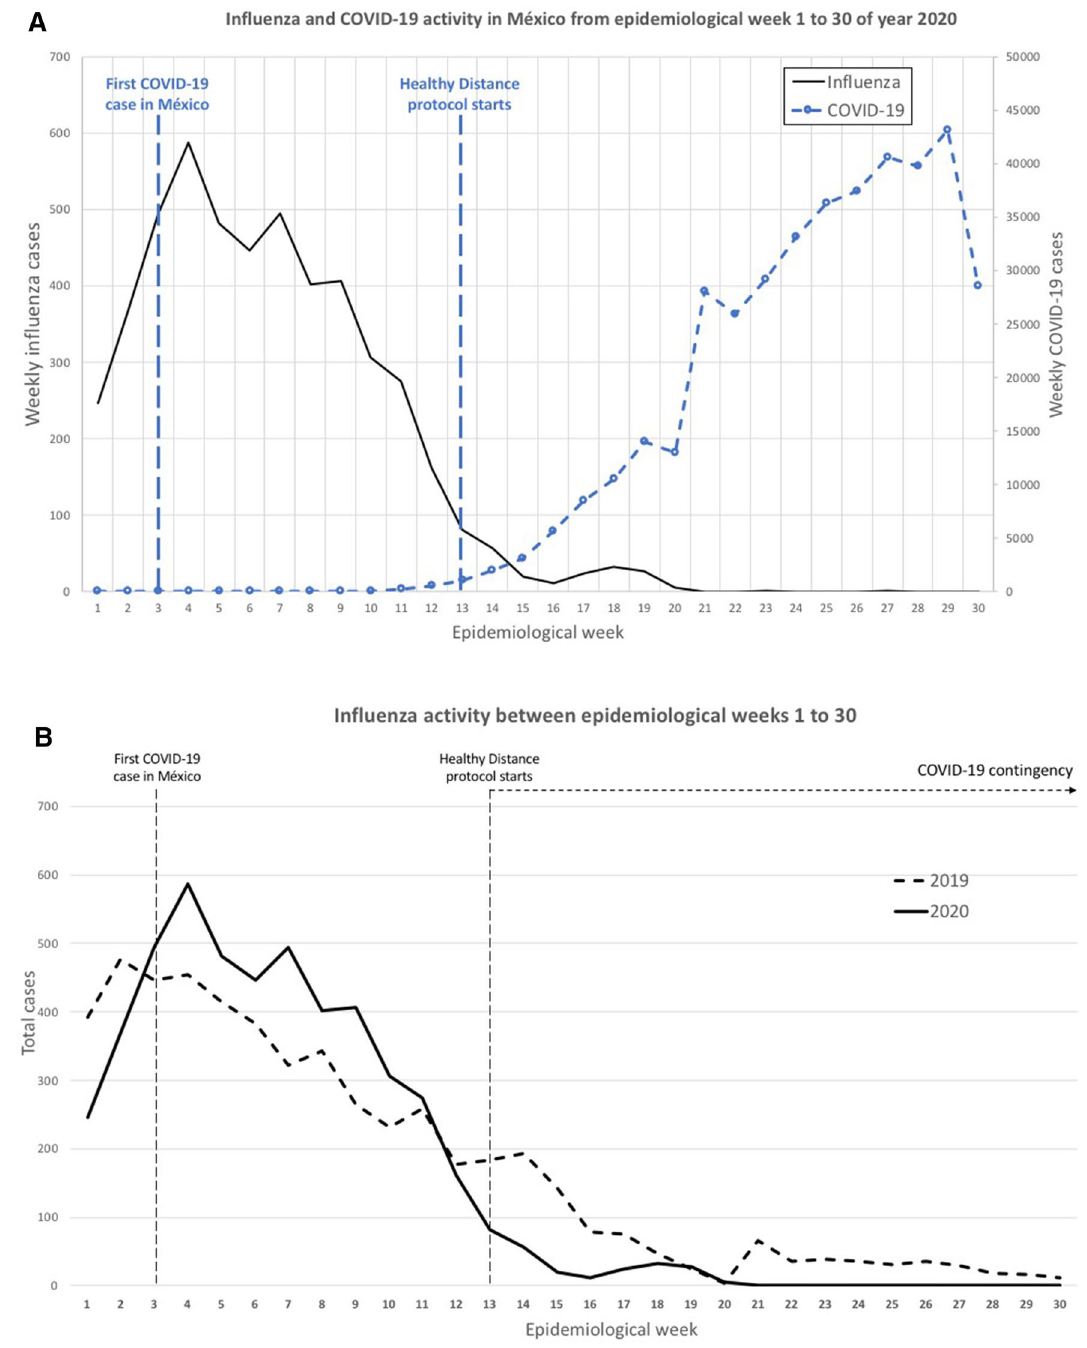
Figure 2. Trends of influenza activity during the 2019–20 season. ( A ) Influenza and COVID-19 activity in México from EPI weeks 1–30 of year 2020; ( B ) Influenza activity between EPI weeks 1–30; ( C ) Influenza deaths comparison between 2019 and 2020 by EPI